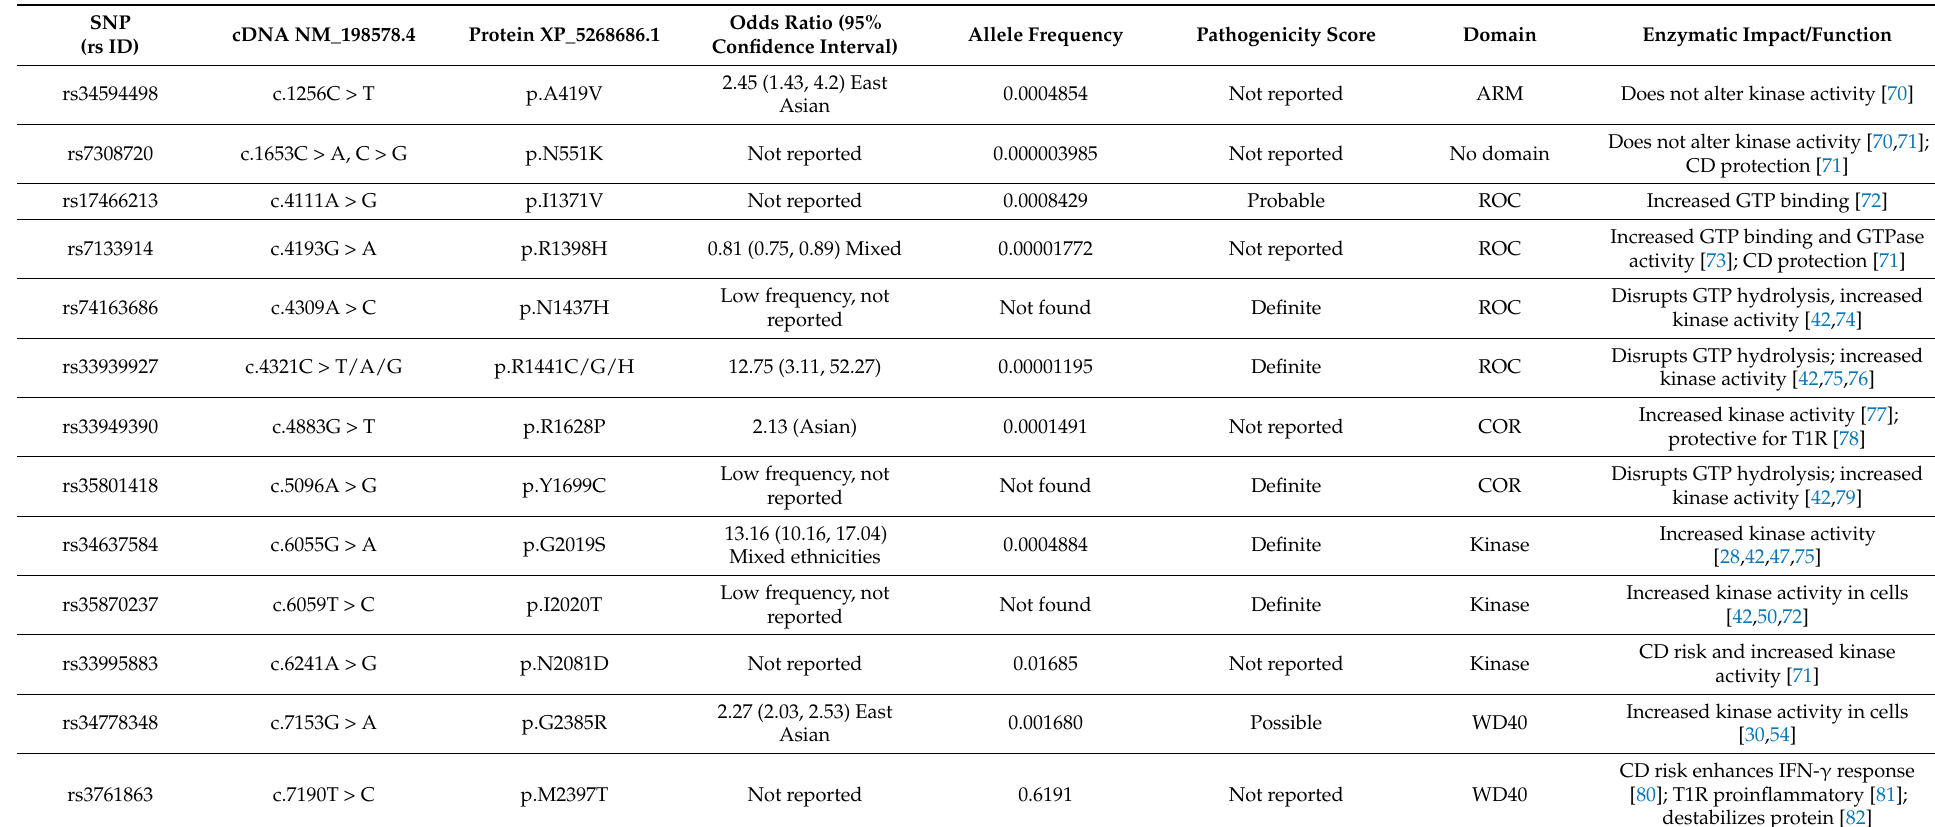
Table 1. LRRK2 variant